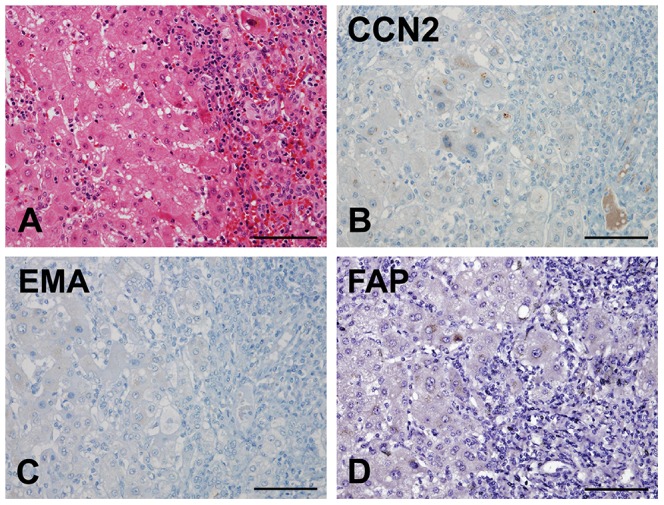
Connective tissue growth factor (CCN2), epithelial membrane antigen (EMA), fibroblast activation protein (FAP), and keratin 19 (K19) expression in liver cirrhosis.A) Liver cirrhosis showing regenerative hepatic nodules and fibrotic septa with chronic inflammatory cells. CCN2 (B), EMA (C), and FAP (D) expression is negative in both hepatocytes and benign stromal cells from cirrhosis specimens. (Scale bars represent 100 µm.)